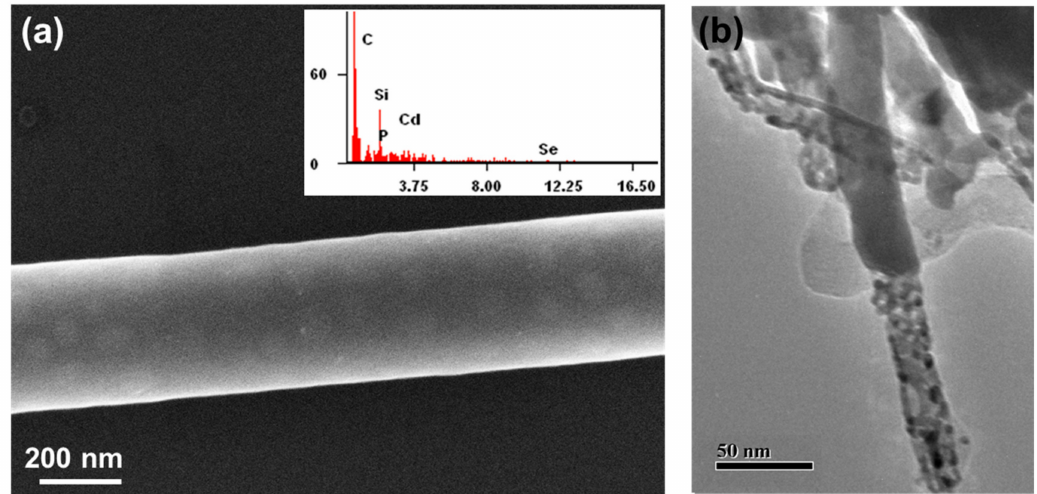
Figure 2. Electron micrographs of the CdSe-embedded PPy nanorods synthesized with di ff erent AAO template pore sizes, ( a ) 300 nm (SEM) and ( b ) 25 ± 5 nm (TEM). The inset in (a) is the EDS spectrum